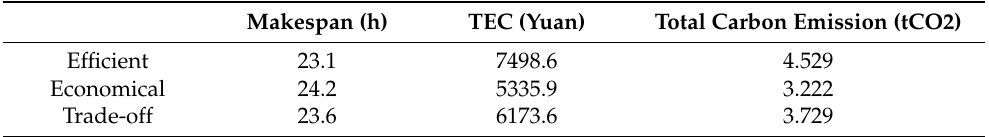
Table 4. Comparison of optimal scheduling